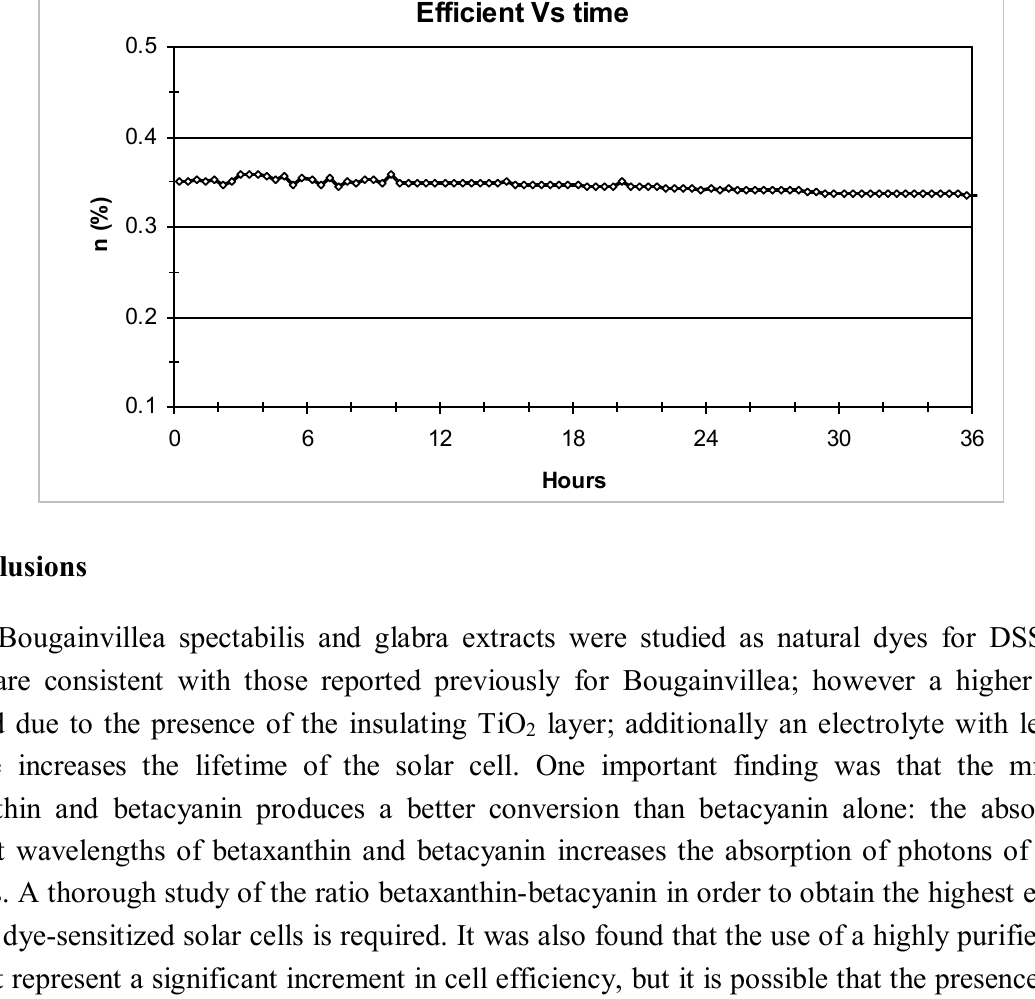
Figure 8. Time dependence of the efficiency for Bougainvillea extract sensitized solar cell. Efficient Vs